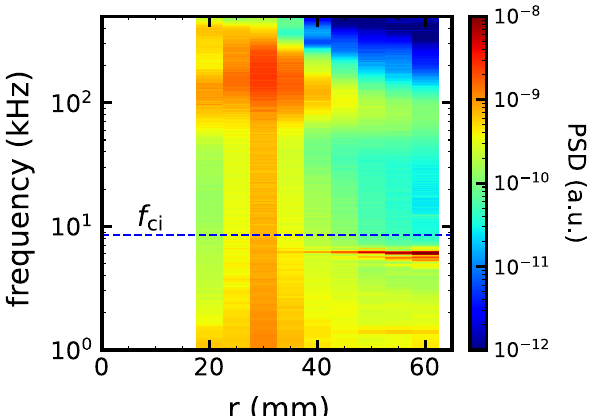
Figure 5. Radial profile of power spectrum density of normalized density fluctuations. Dashed line indicate the ion cyclotron frequency f ci